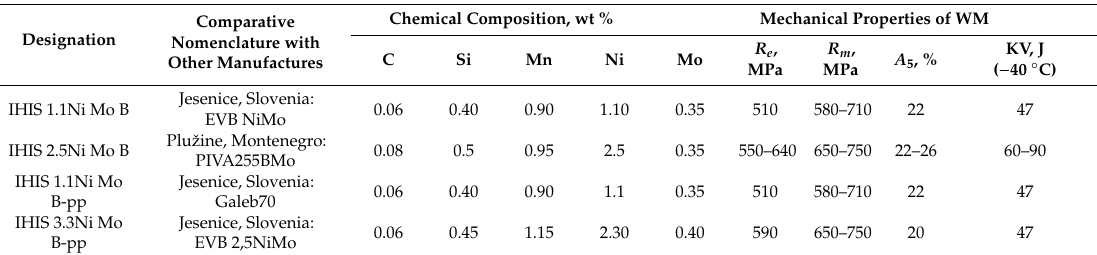
Table 2. Designations of the coated electrodes, their chemical composition, and mechanical properties of weld metal (WM), according to the specifications of the